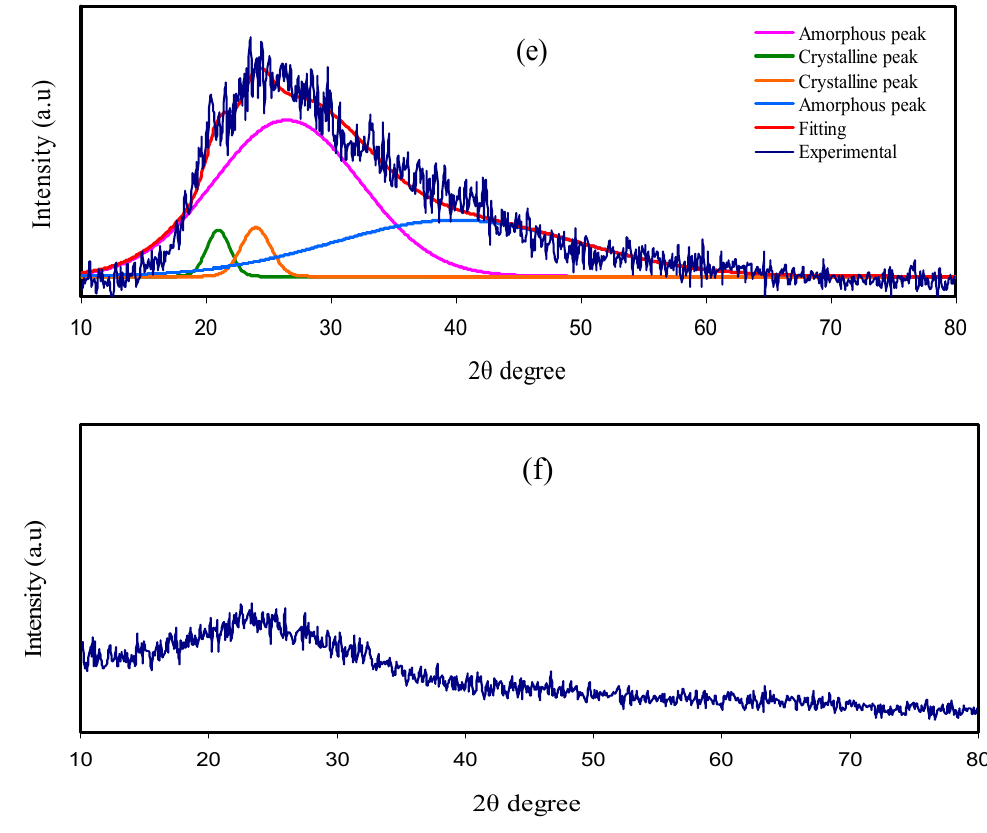
Figure 1. Deconvoluted XRD spectra for ( a ) pure PVA, ( b ) PNCG-1, ( c ) PNCG -2, ( d ) PNCG-3, and ( e ) PNCG-4 films, and ( f ) synthesized Table 1 . The degree of crystallinity from deconvoluted XRD analysis.